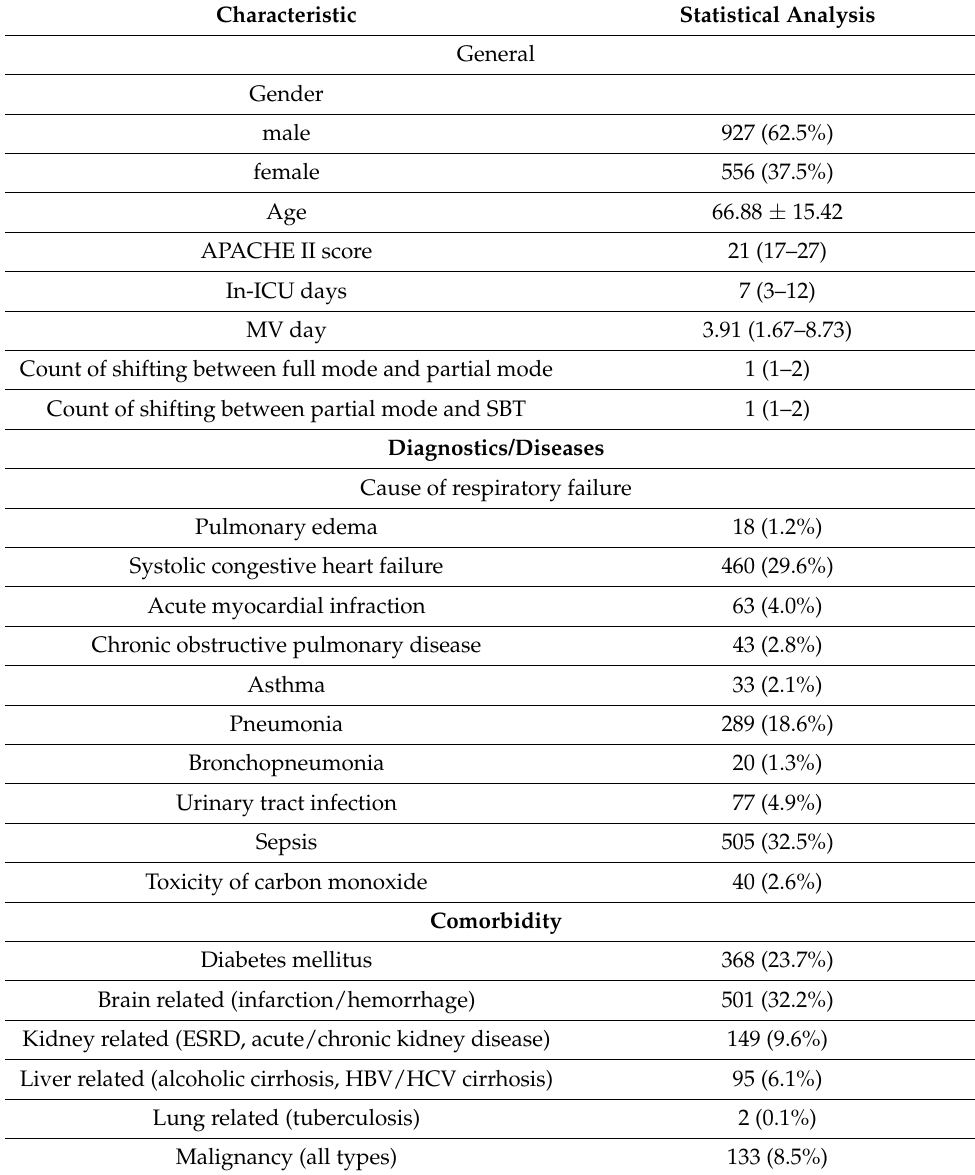
Table 2. Characteristics of the study